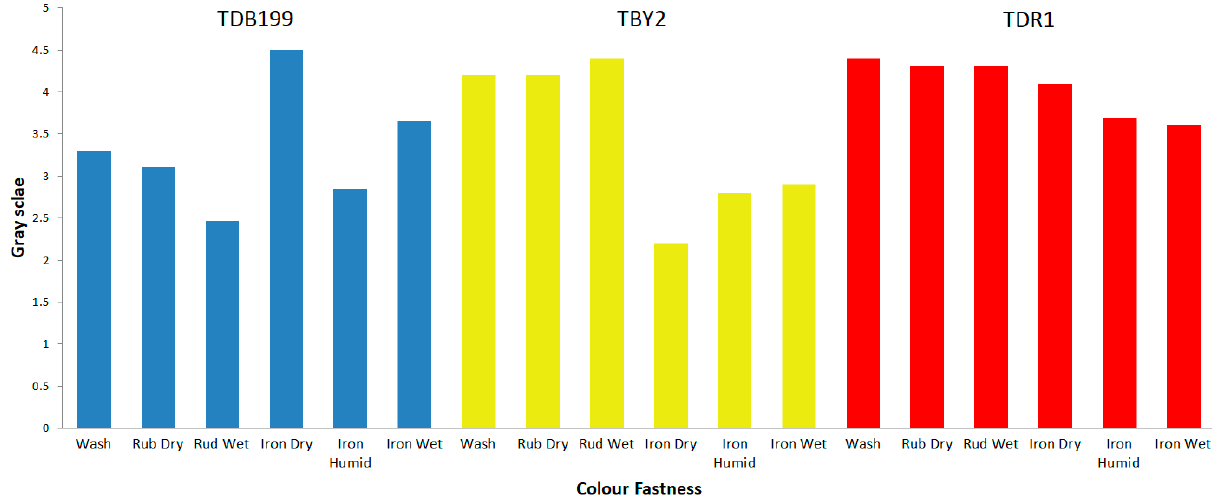
Figure 7. Colour fastness values by greyscale index.